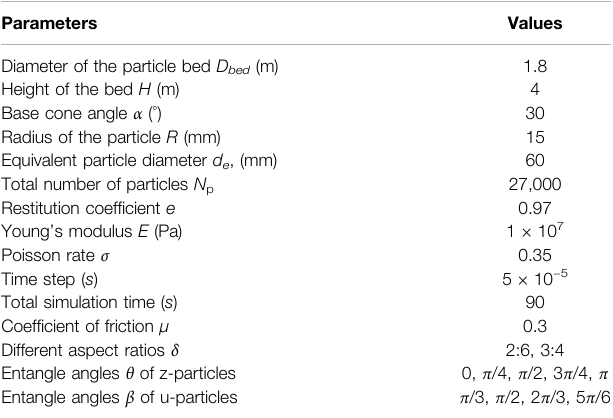
TABLE 1 | Particle shape parameters used in simulation cases. Parameters